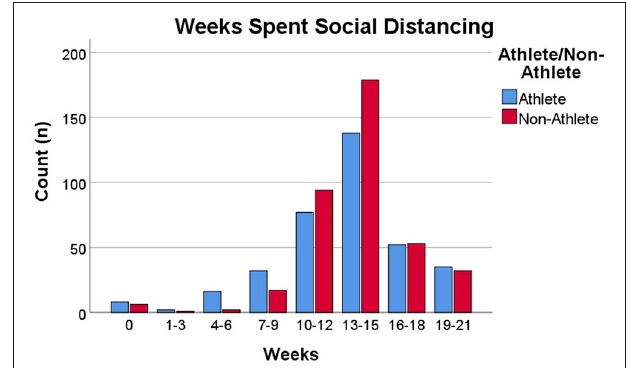
FIGURE 3 | Weeks spent social distancing by both athletes and